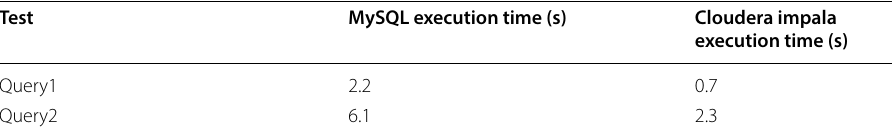
Table 3 MySQL vs Cloudera performance